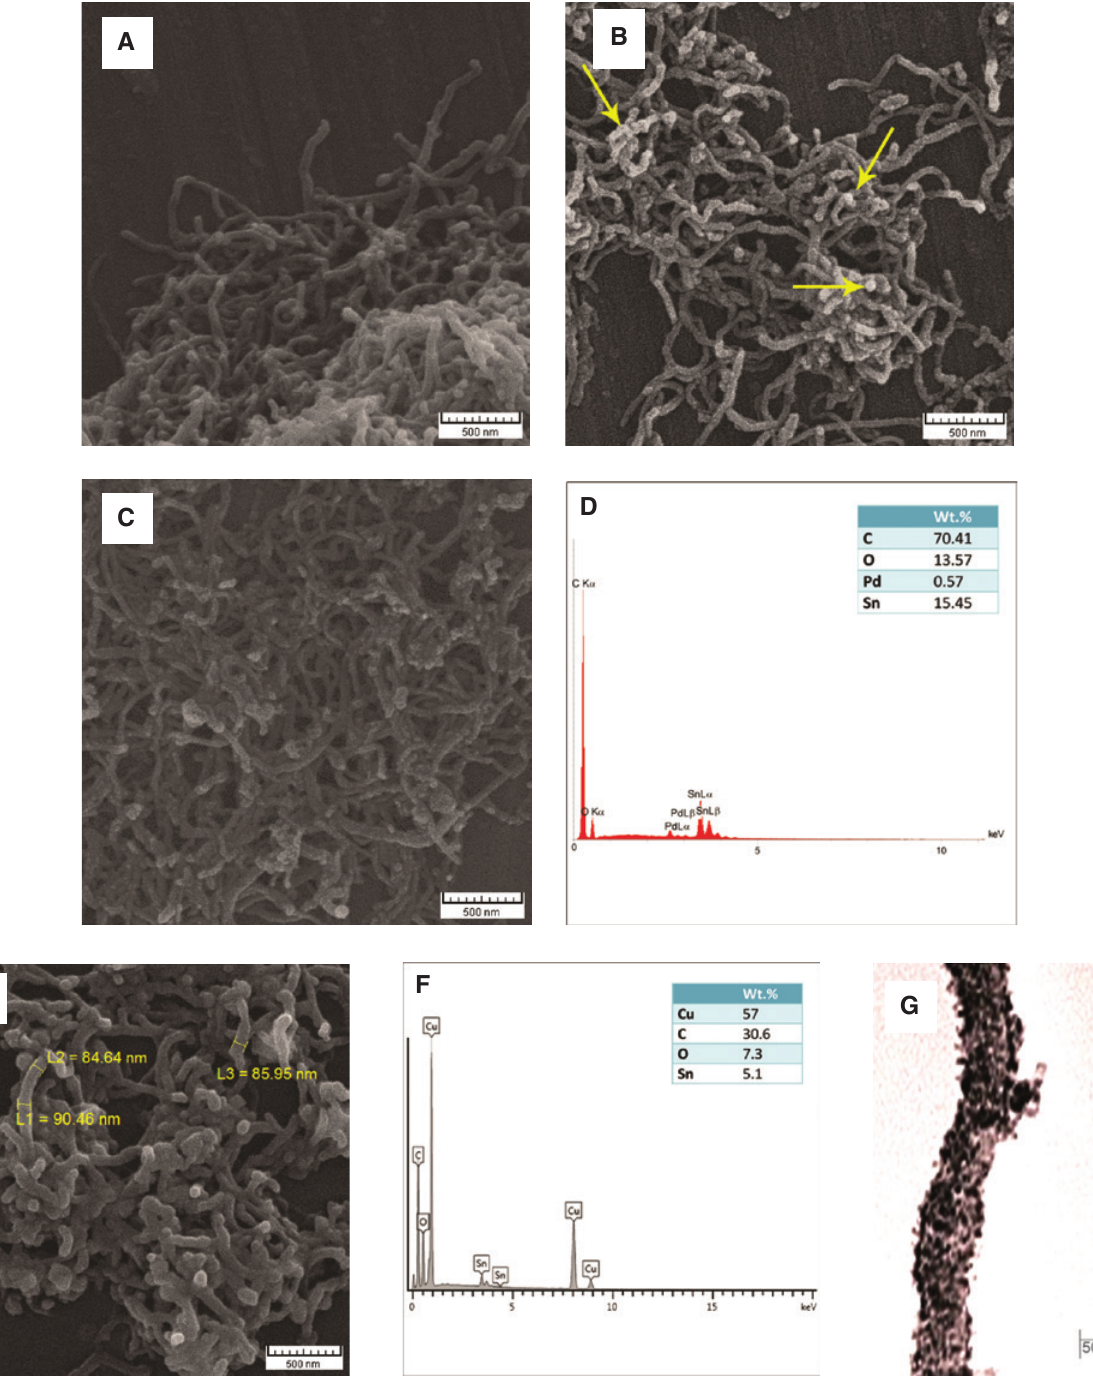
Figure 3: SEM micrographs of (A) as-received MWCNTs, (B) sensitized MWCNTs, (C) activated MWCNTs, (E) copper-coated MWCNTs. EDX spectrum of (D) activated MWCNTs and (F) copper-coated MWCNTs. (G) TEM observation of a single-coated